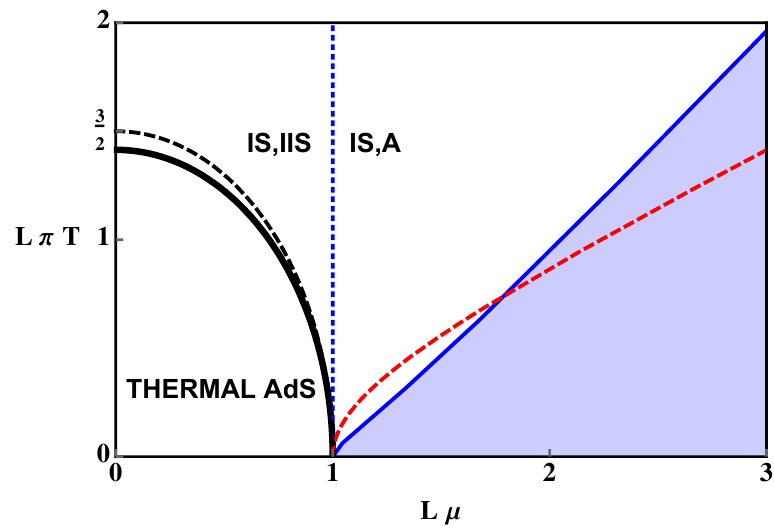
Figure 1 . Phase diagram in the grand canonical ensemble for three equal chemical potentials. Susceptibilities diverge at the black thick curve, and black hole solutions exist only in the region outside the curve. The red dashed curve marks the onset of the instability for the symmetric phase ( IS ) at higher values of the chemical potential. The blue dashed curve at L(cid:22) = 1 separates the unstable symmetric ( IIS ) and asymmetric ( A ) phases. The black dashed curve corresponds to the Hawking-Page transition. The colored region shows where the black hole is unstable to brane nucleation. Outside that region and to the right of the L(cid:22) = 1 line the probe D3-brane e(cid:11)ective potential has a minimum away from the horizon, but the nucleation instability is suppressed due to the mechanism described in the text (typical branes in the stack do not spin fast